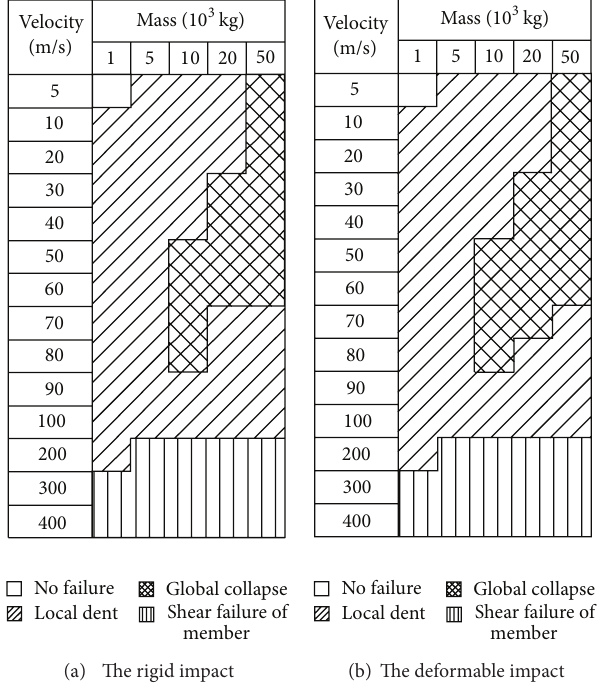
Figure 9: Comparison of the impact events with the roof load of 60 kg/m 2 between the rigid impact and the deformable impact.